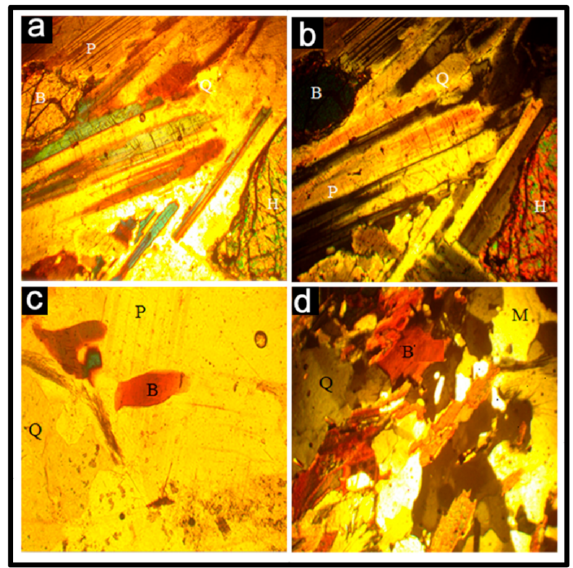
Figure 8. Photomicrographs of some of the rock samples collected during field investigation: ( a ) and ( b ) hornblende granite gneiss showing feldspars and micas (biotite) indicate some preferred orienta- tions, under parallel and cross nicols, ( c ) section of granitic pegmatite showing large crystals under parallel nicols, and ( d ) section of a migmatite under cross nicols showing the distribution of biotite, quartz,